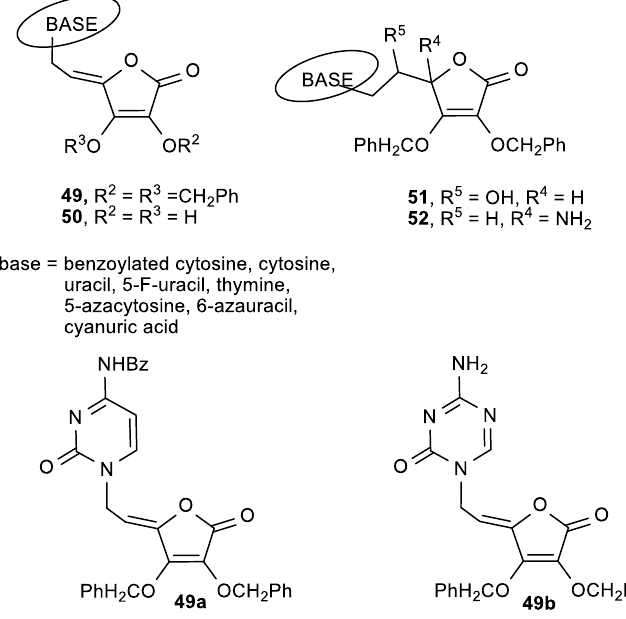
Figure 22. Novel 5- or 6-azapyrimidine and cyanuric acid ASA derivatives. Table 21. The cytostatic activities of the cytosine ( 49a ) and 5-azacytosine ( 49b ) ASA derivatives. Comp.